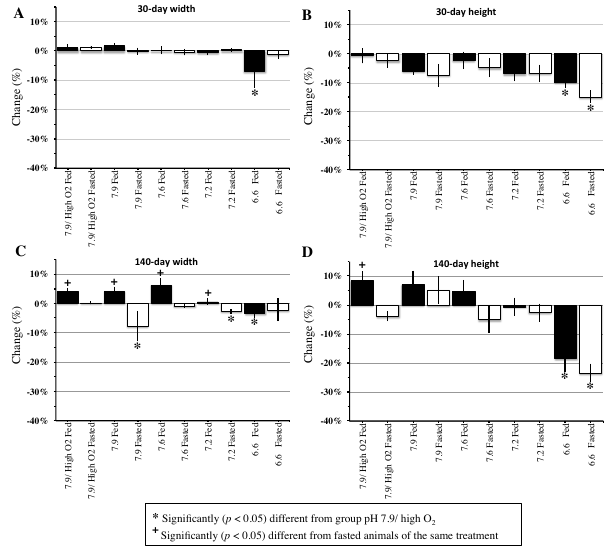
Fig. 5. S. fragilis changes in width ( A and C ) and height ( B and D ) are shown following 30 ( A and B ) and 140 ( C and D ) days of ex- posure to extreme (pH 6.6), high (pH 7.2), moderate (pH 7.6) and control (pH 7.9) p CO 2 at in situ O 2 levels, and to control p CO 2 (pH 7.9) at 100% air saturation, following a feeding (filled bars) or fast- ing (unfilled bars) regime. Change in size is shown as mean ± SEM.